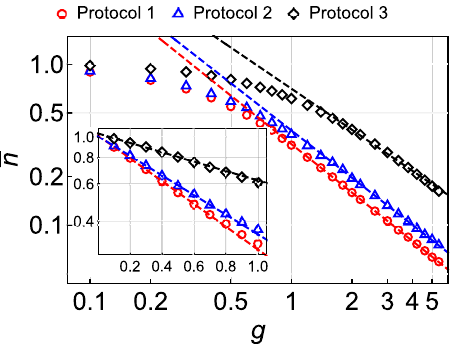
Fig. 2 Scaling of the excitation number. Numerically found fi nal normalized excitation number (cid:2) n (cid:2) h n i = ðð N (cid:3) 1 Þ = 2 Þ at various g = τ a / τ I for N = 12 spins for three different protocols listed in Table 1. The Hamiltonian H I takes the form (2) with the coupling coef fi cients independently drawn from the standard normal distribution. The main fi gure and inset show the adiabatic (large g ) and nonadiabatic (small g ) regimes in log – log and semi-log scales, respectively. The solvable protocol (red points) always outperforms the other protocols for the same g